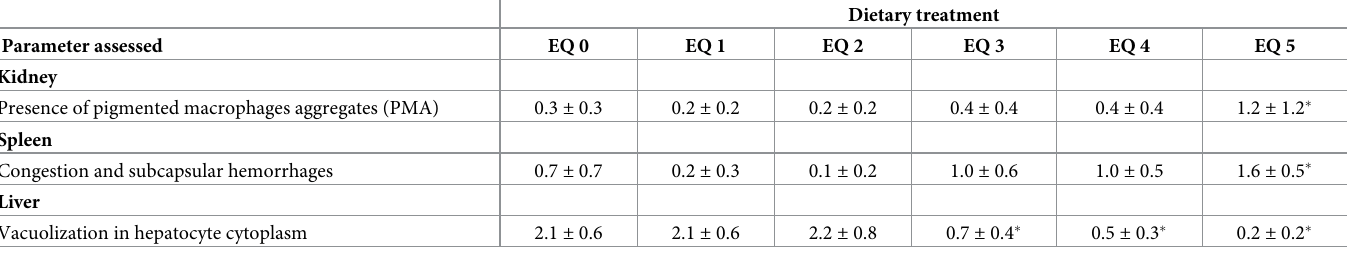
Dietary treatment